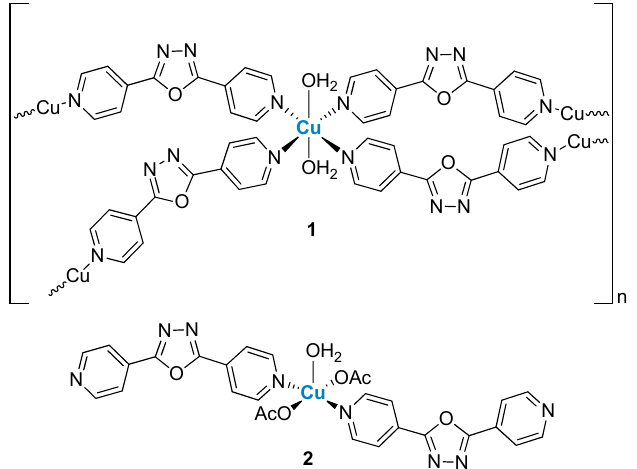
Figure 2. Structures of two Cu(II) complexes with the ligand 2,5-bis(4-pyridyl)-1,3,4-oxadiazole. When the same reaction was performed using Cu(II) acetate instead of the perchlorate salt the authors did not obtain a coordination polymer but an unexpected mononuclear complex (compound